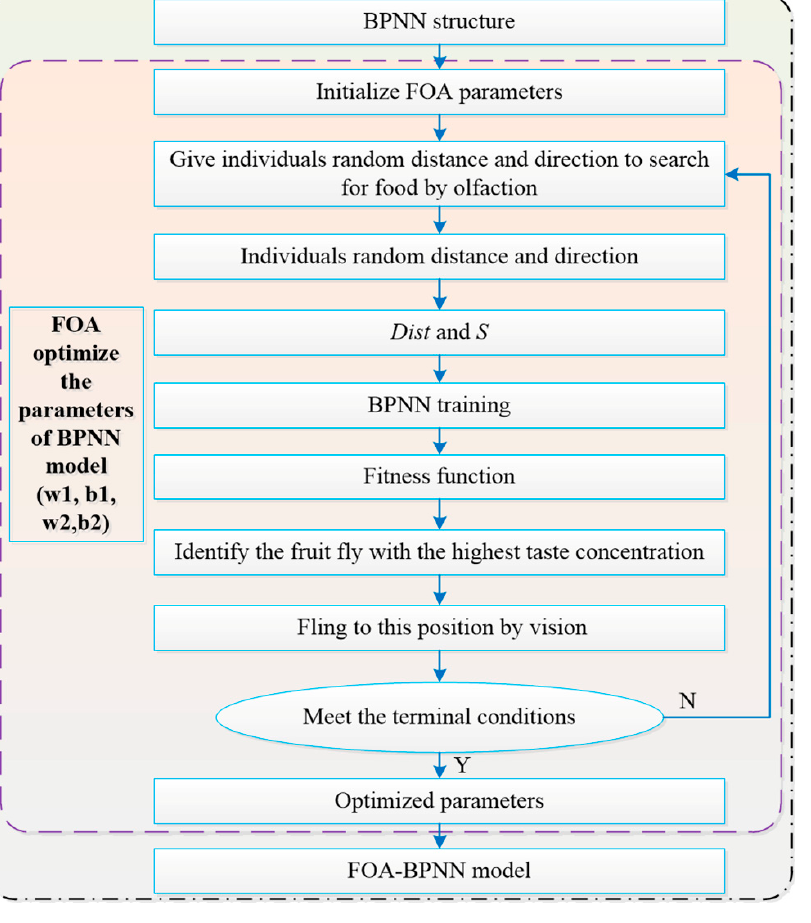
Figure 3. Optimization procedure of an FOA-BPNN.